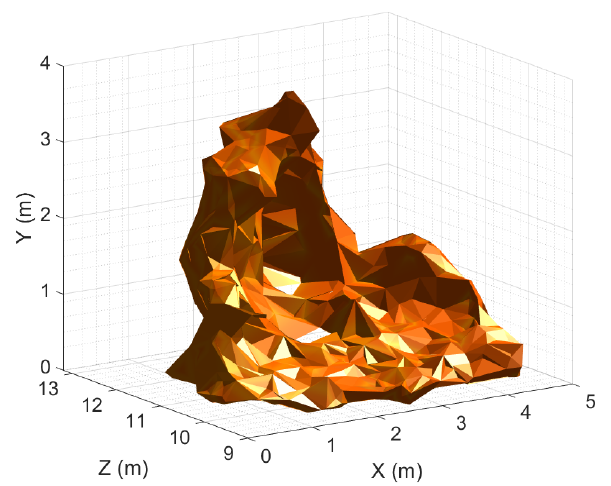
Figure 11. 3D reconstruction with Delaunay triangulation of the fire shown in Figure